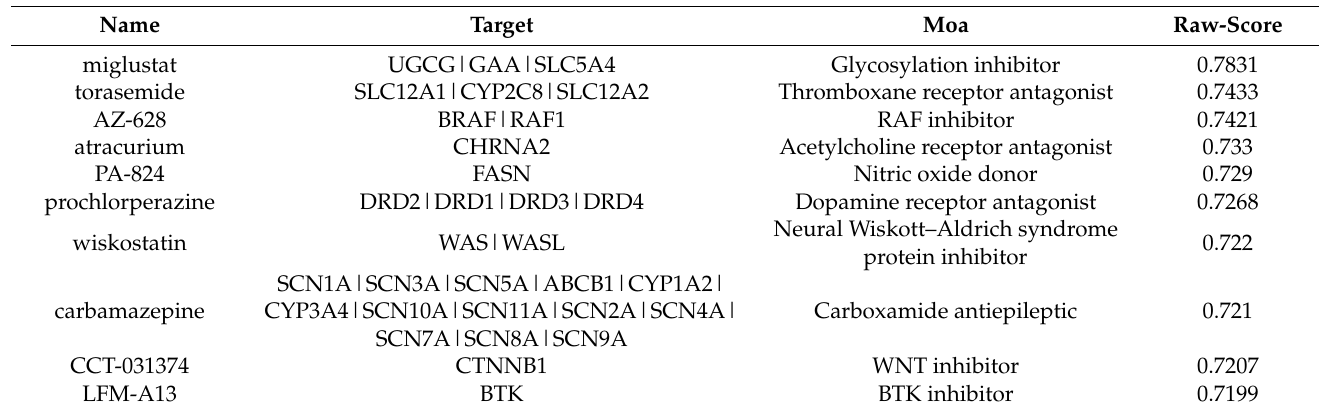
Table 1. The predicted antagonistic molecules for RCC using the cMAP database. The antagonistic molecules were screened for RCC by cMAP analysis of 82 candidate hub genes. The top 10 ranked molecules are listed in this table. These molecules can induce opposite disturbances in RCC. Thus, these molecules can be candidate drugs for the treatment of